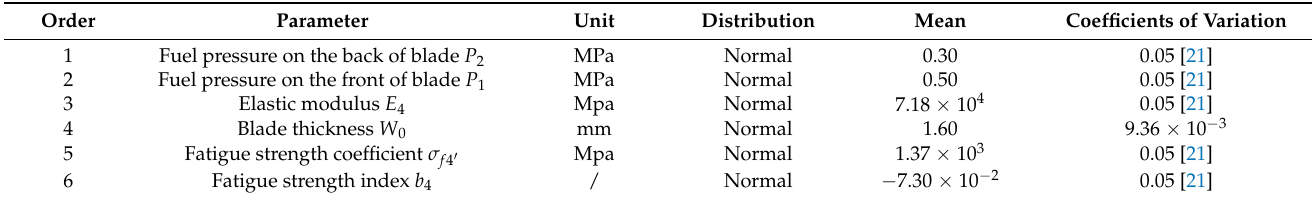
Table 5. Statistical information of the design parameters of the